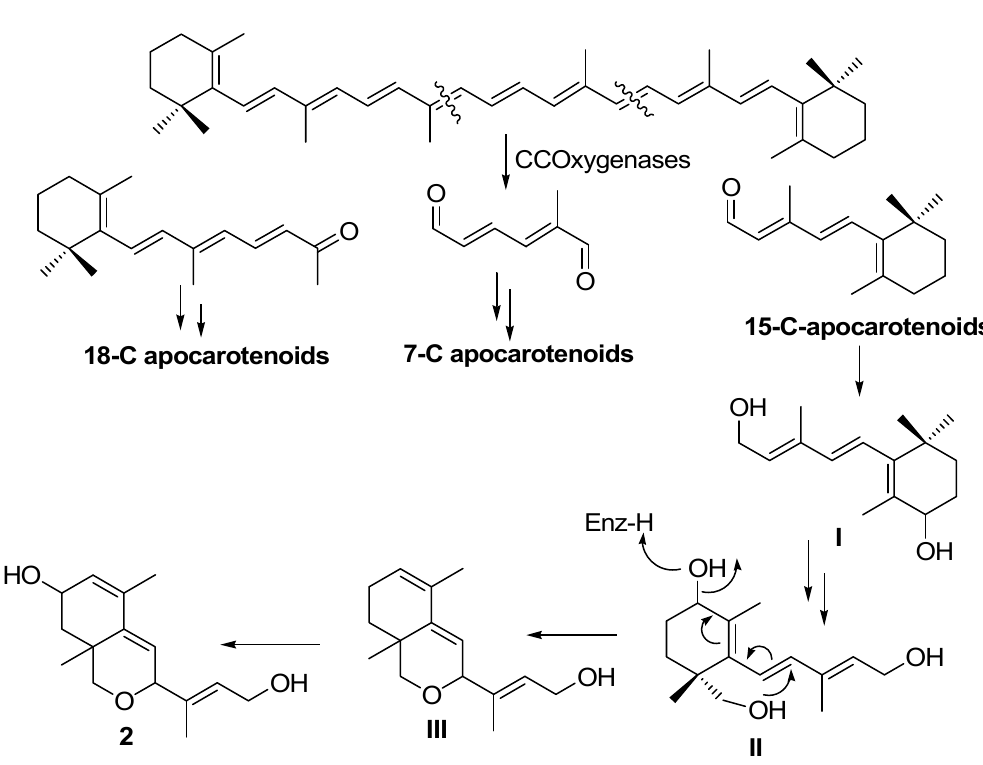
Scheme 1. Biosynthetic pathway of apocarotenoid 2